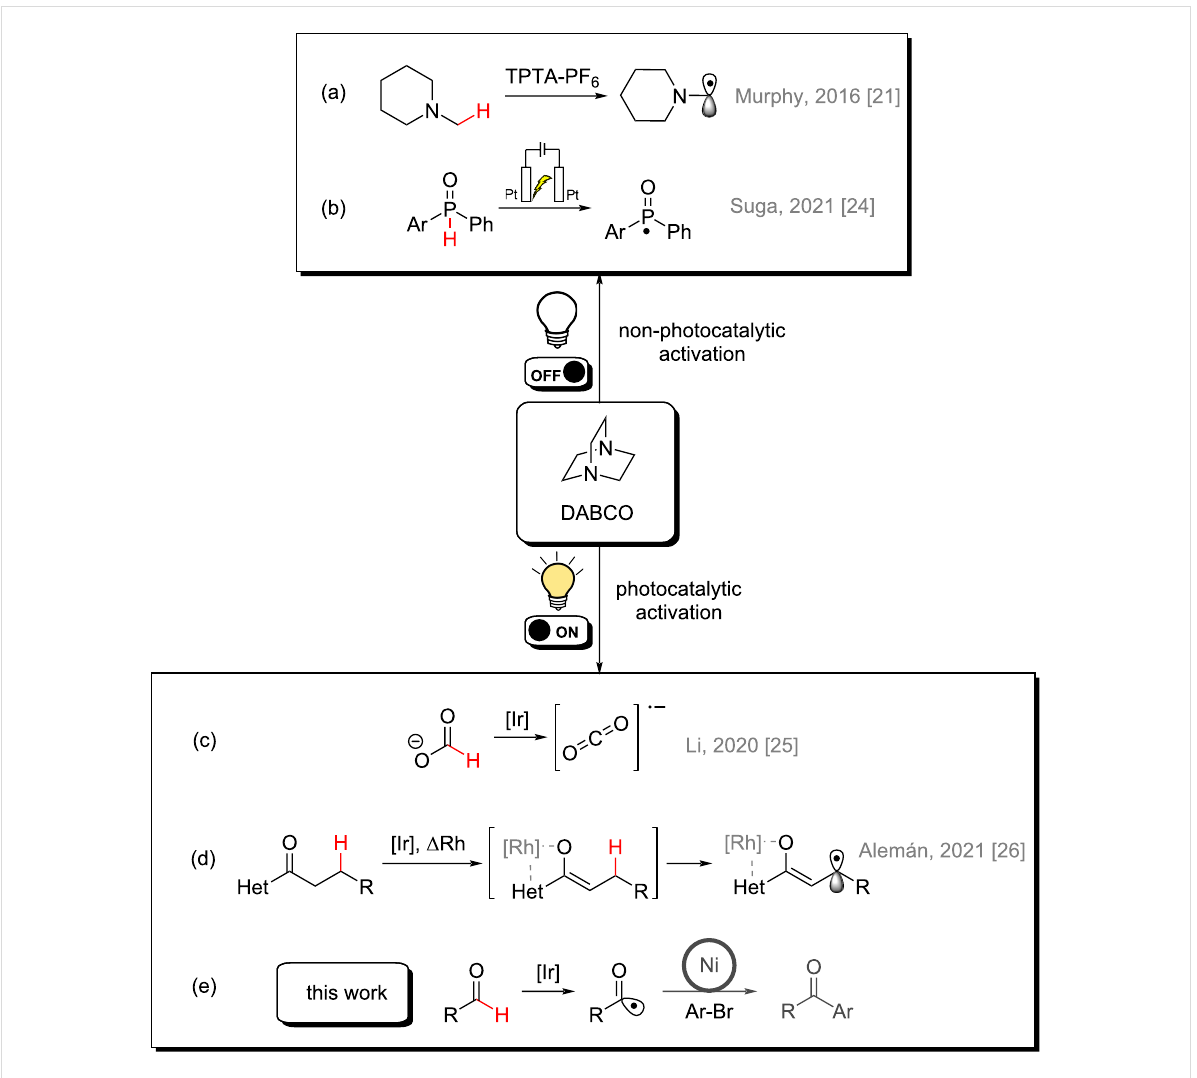
Figure 2: Previous reports of DABCO as hydrogen abstractor in HAT reactions and this work.